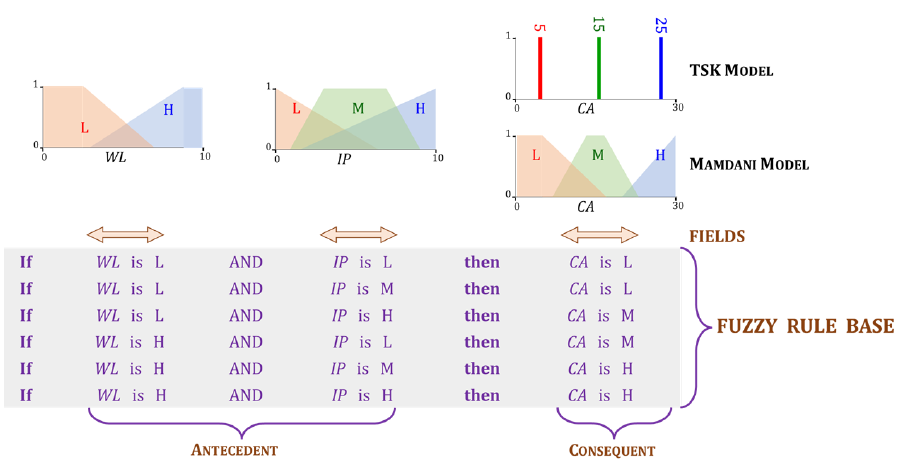
Figure 9. Fuzzy inference system. The figure shows membership functions ( top ), and fuzzy rule base ( bottom ). The input x has two elements, WL ∈ [ 0,10 ] (wheel load), that can be L (Low), M (Medium), or H (High), and IP ∈ [ 0,10 ] (inflation pressure) that can be L (Low) or H (High). The output y ∈ [ 0,30 ] is a scalar ( N = 1). This is the quantity CA (contact area), which can be L (Low), M (Medium), or H (High). The membership functions, µ L ( CA ) , µ M ( CA ) , and µ H ( CA ) are trapezoids/triangle (Mamdani) or singletons